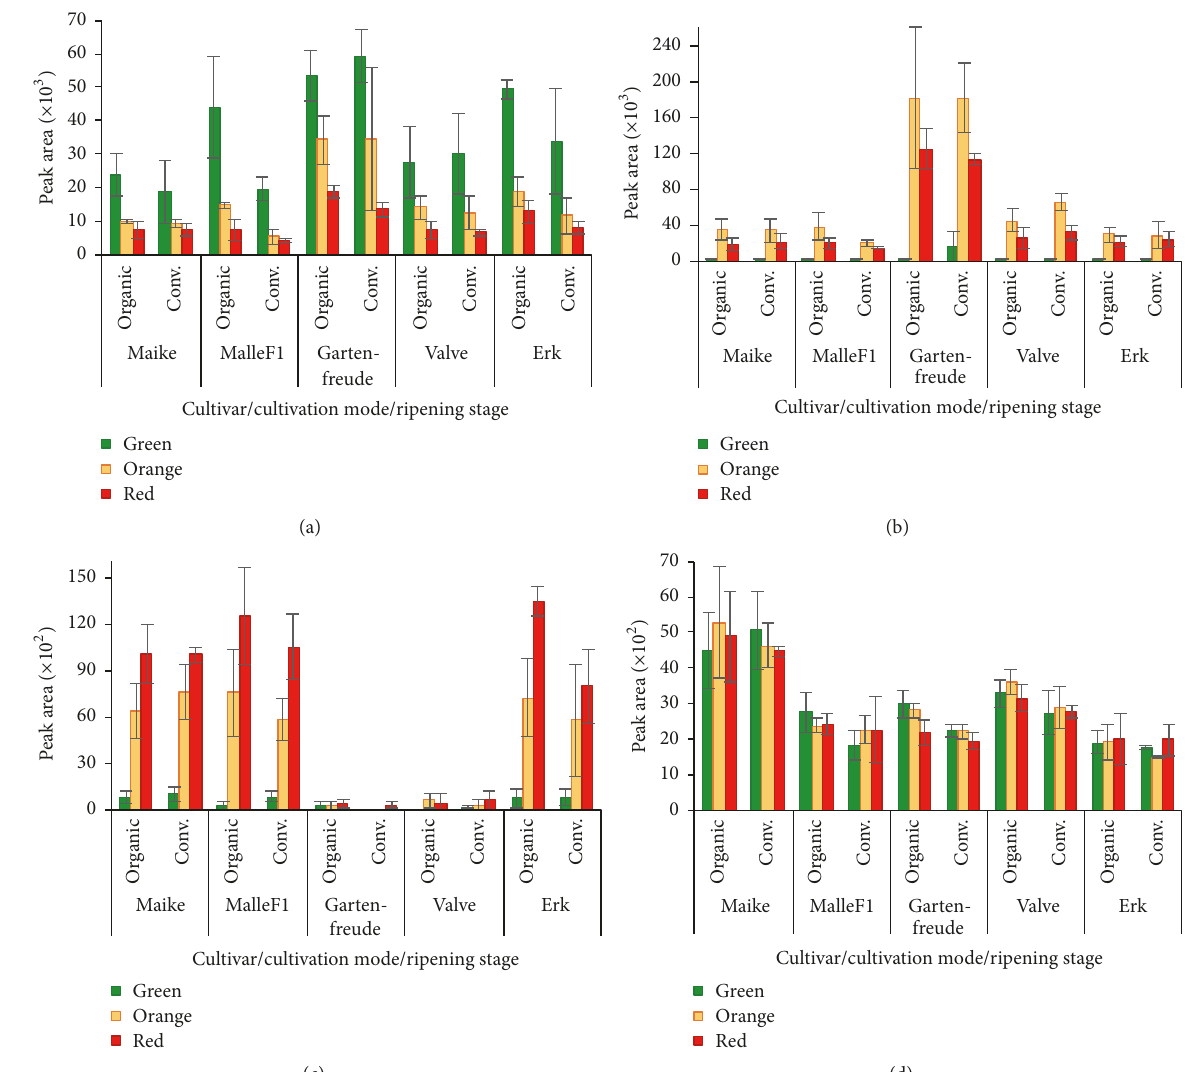
Figure 2: Dynamic patterns of polyphenols (mean ± standard deviation of EIC peak area) during ripening of tomato fruits. Four compounds (named in parenthesis) were selected as examples of different patterns: (a) decreasing trend (chlorogenic acid), (b) increasing and then decreasing trend (naringenin glucoside), (c) continuous increasing trend (apigenin acetylhexoside), and (d) high concentrations already in green fruits and minimal changes during ripening (kaempferol rutinoside